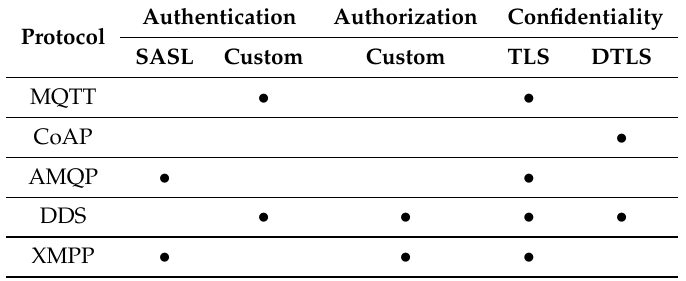
Table 2. Summary of the security services supported by the messaging